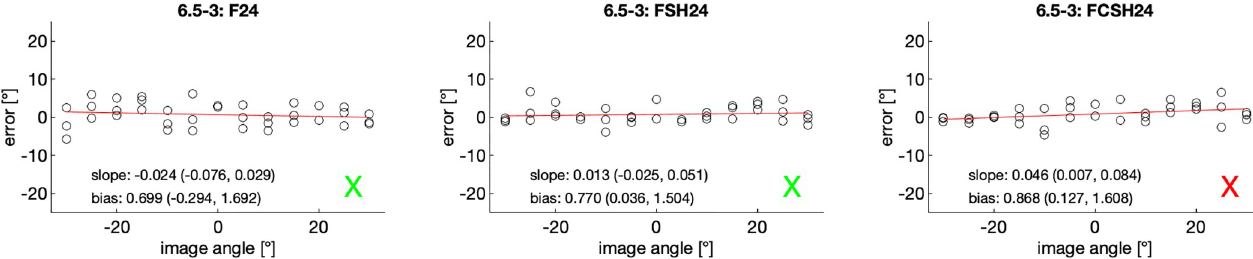
Fig 5. Error in measuring abutment angle using ultrasonic imaging as a function of image angle. In this particular example, abutment type 6.5–3 was measured using 3 imaging modes, i.e., F24, FSH24, and FCSH24, depicted above from left to right. For each imaging mode the image angle was arranged from -30˚ to +30˚ and three estimates of the abutment angle were taken. The resulting error was then fit using a 1 st order polynomial. Slope and bias with 95% confidence interval are provided for each imaging mode. A red ‘X’ indicates a slope being significantly different from zero; and ‘X’ is vice